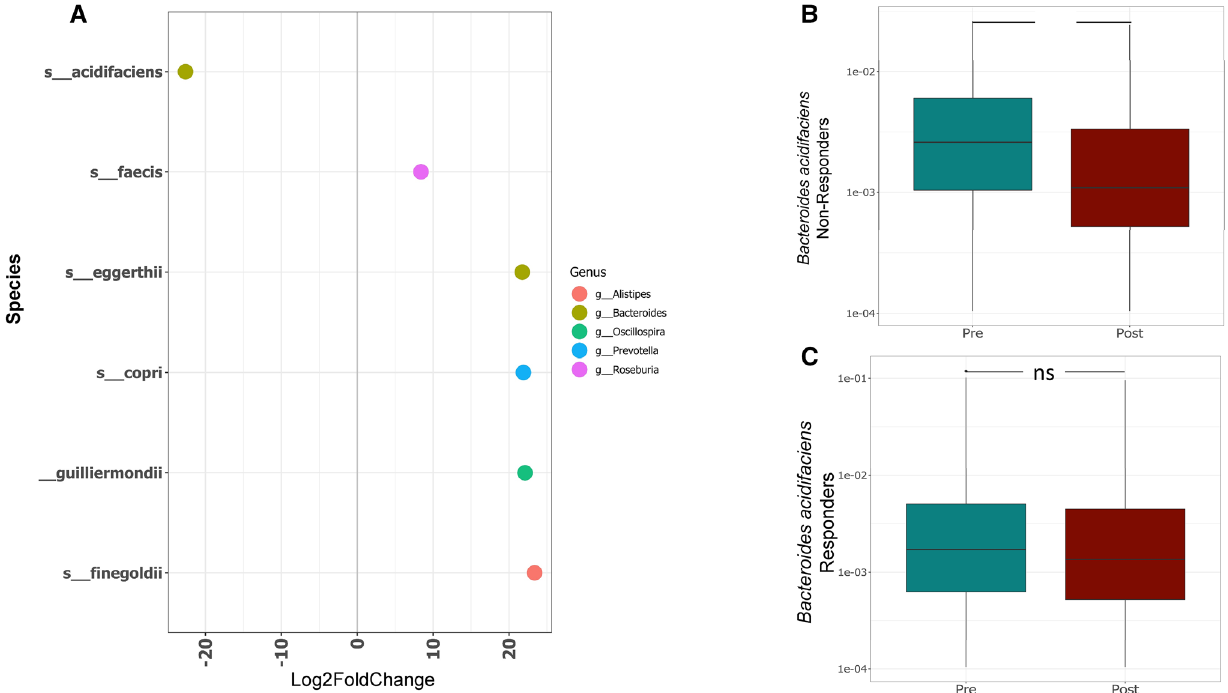
Figure 5. Species level comparison within gut microbiota of responders and non-responders to vitamin D supplementation. ( A ) DESeq2 differential abundance analysis of significantly different OTUs post/pre in non-responders ( p < 0.05, FDR-corrected); OTUs to the right of the zero line were more abundant in non- responders post- supplementation and OTUs to the left of the zero line were less abundant. ( B – C ) Comparison of relative abundance of B. acidifaciens in non-responders ( B ) and responders ( C ) pre- and post-vitamin D supplementation. Significant decrease in non-responders post supplementation (** P < 0.01). Responders show non-significant change. Statistical significance was identified by the Wilcoxon test with false discovery rate (FDR)-Bonferroni corrected pairwise P values. * P < 0.05; ** P < 0.01). The figure was generated using (RStudio v 1.2 with R v 3.6) 87